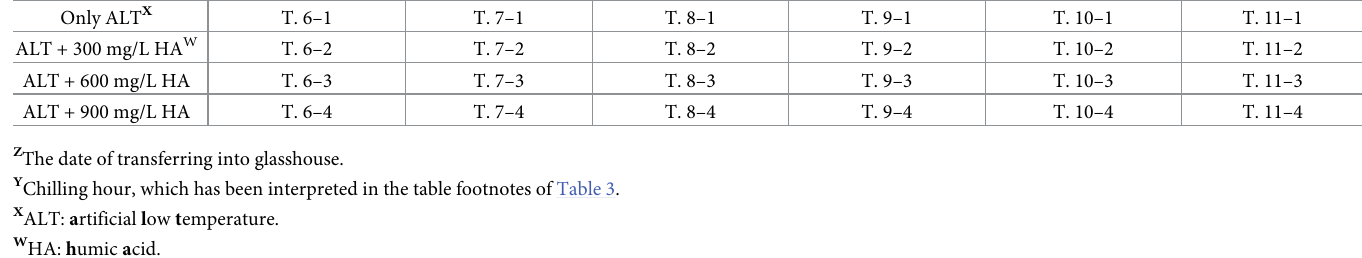
Table 4. Detail of 24 treatments for the forcing culture of ‘Hang Baishao’ under artificial low temperature and HA treatment. Treatment